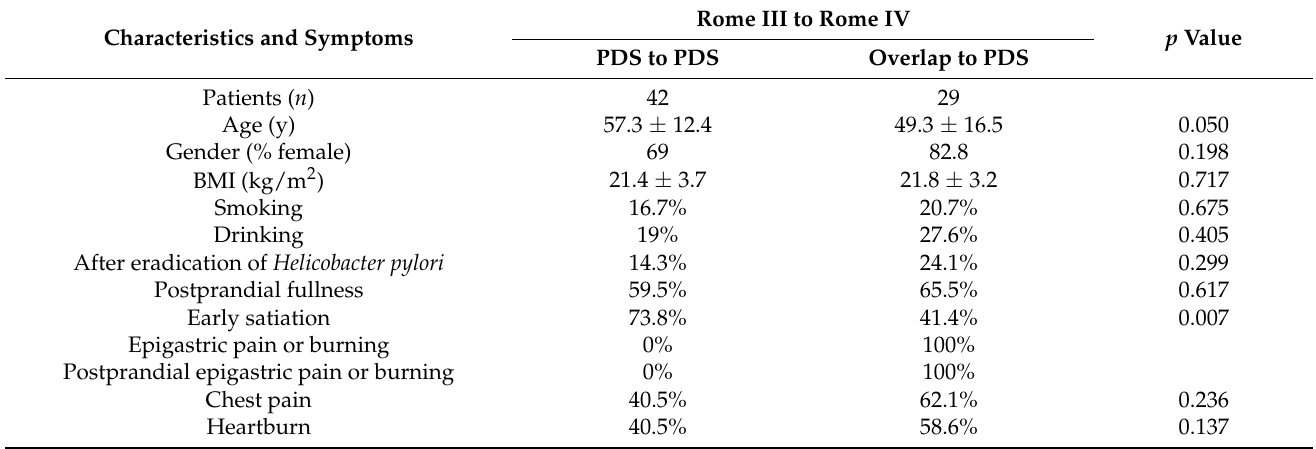
Table 2. Characteristics and symptoms between the Rome III and IV criteria.